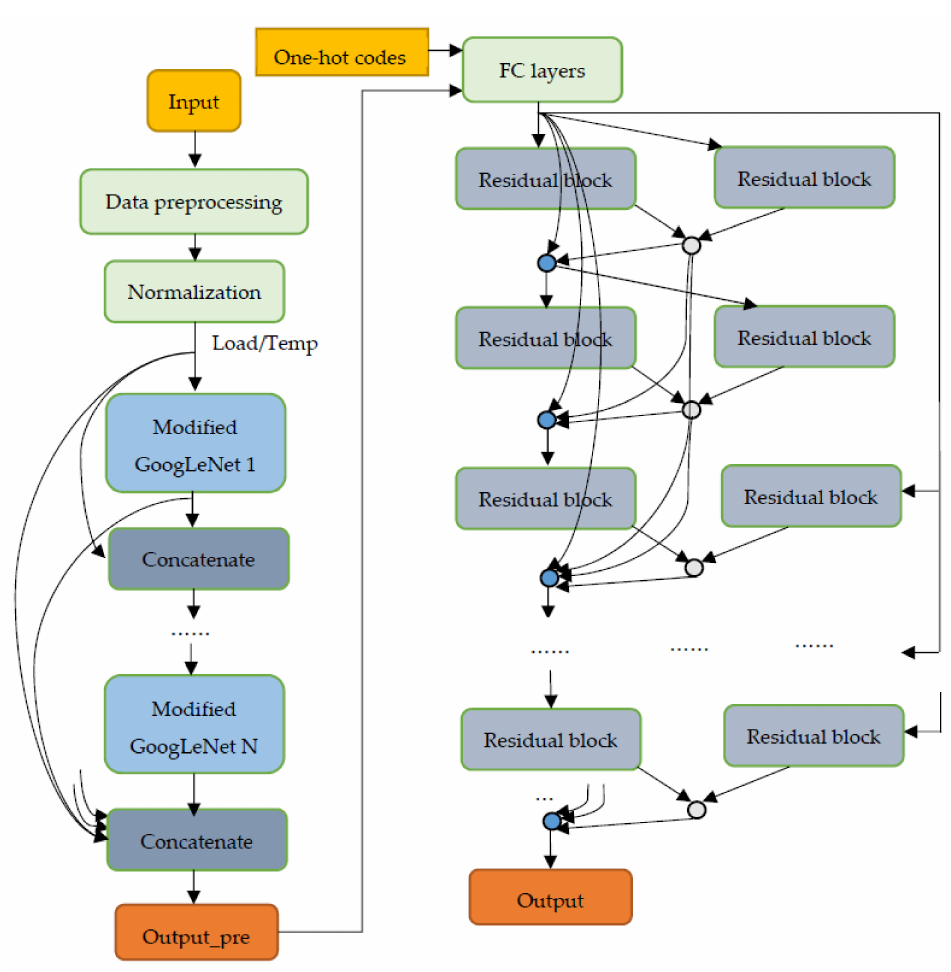
Figure 6. The structure of the proposed